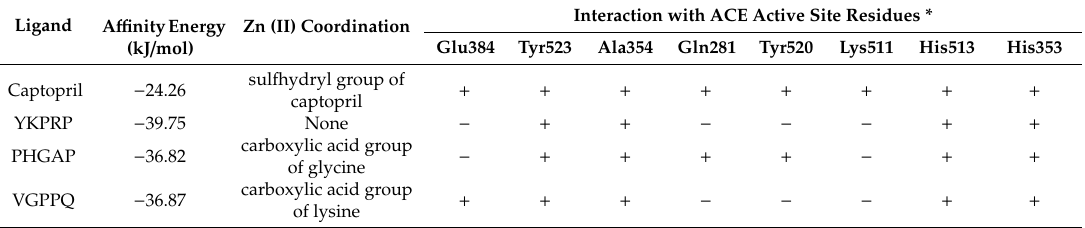
Table 3. Predicted binding energies, ZN(II) coordination, and ACE residues that interact with the docked